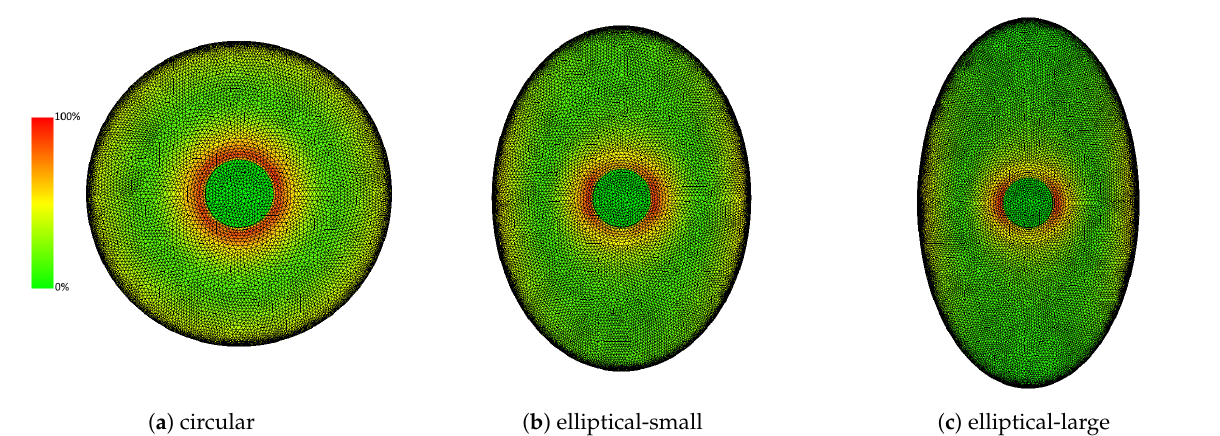
Figure 4. Comparison of stress in the three configurations (circular and small/large